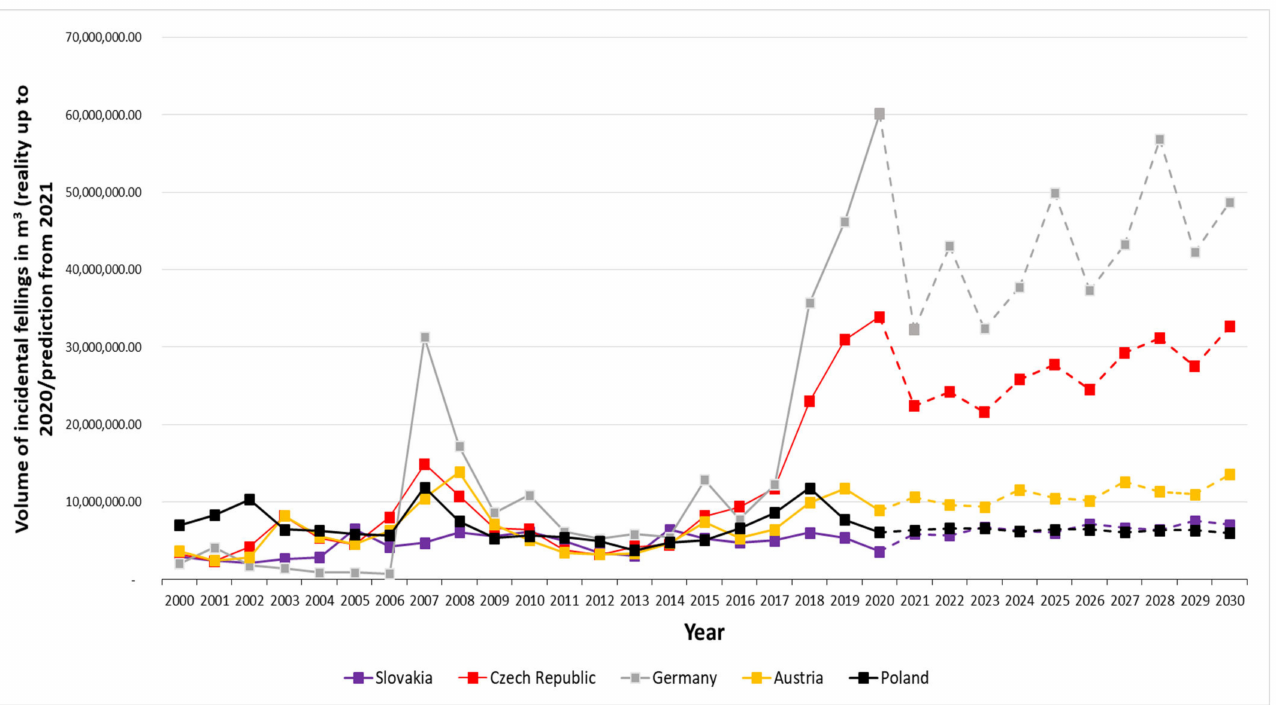
Figure 5. Volume development of incidental fellings and prediction from 2021 onward in selected European countries in the time range